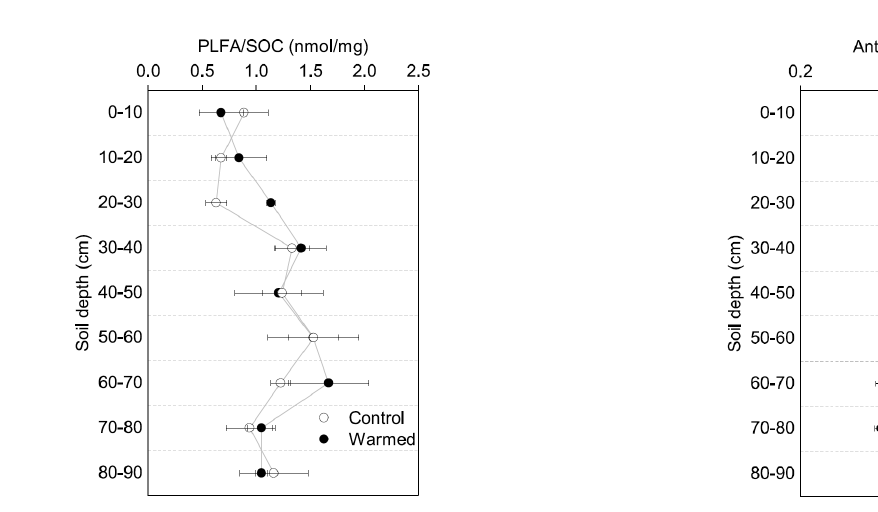
Figure 2. Proportion of PLFAs to SOC in control and warmed plots after 4.5 years of + 4 ◦ C soil warming (mean ± SE; n = 3).